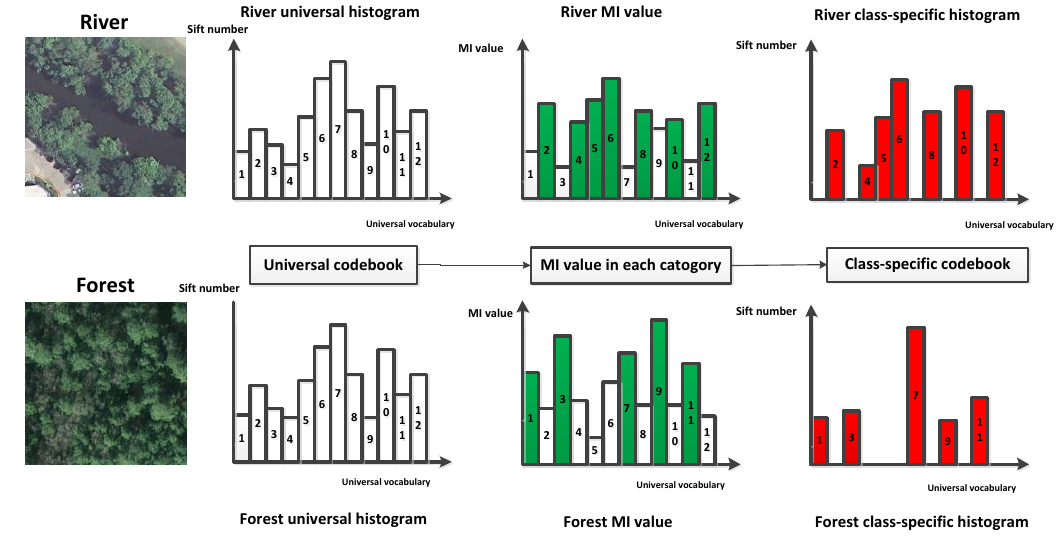
Figure 6. Procedure of generating class-specific histogram.